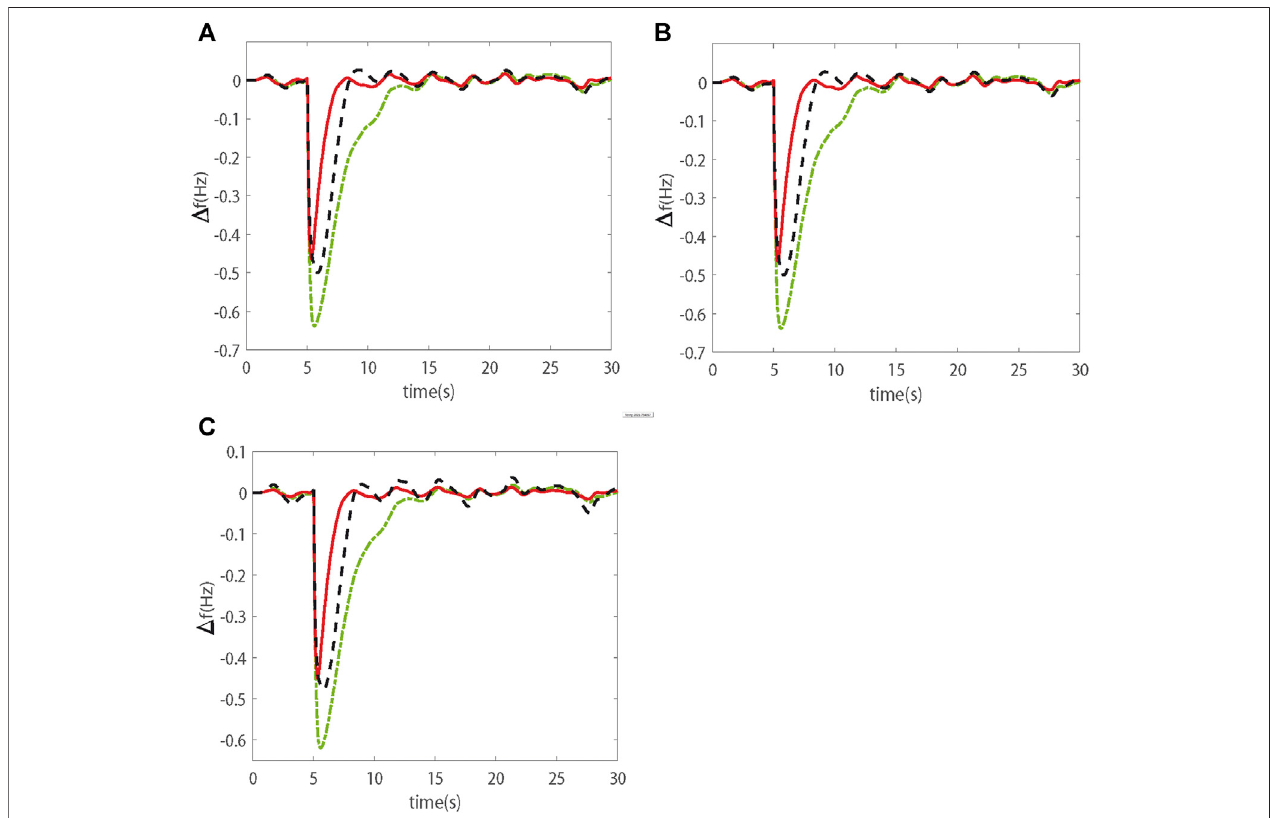
FIGURE 4 | Frequency deviation from different control methods in three scenarios with big load change in variable high wind speed, (A) is Scenario 1, (B) is Scenario 2 and (C) is Scenario 3: dash-dot (RSC), dashed (RSC with IC), solid (RSC with DSR).